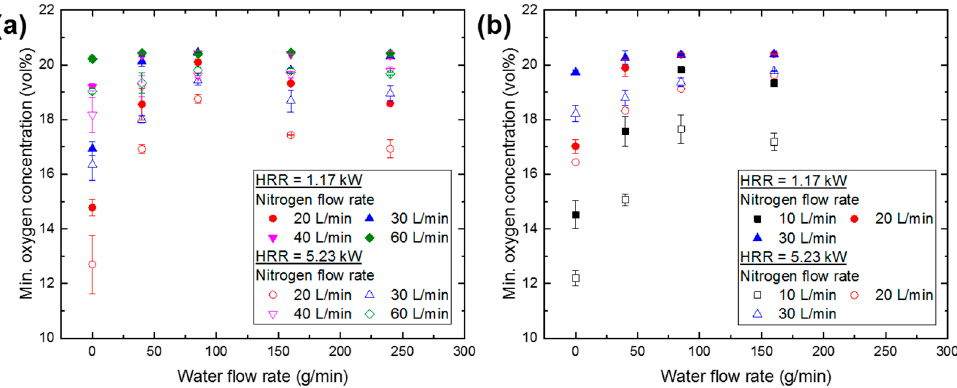
Figure 7. Minimum oxygen concentration for large and small atomizers under different HRR conditions: ( a ) large atomizer and ( b ) small atomizer.